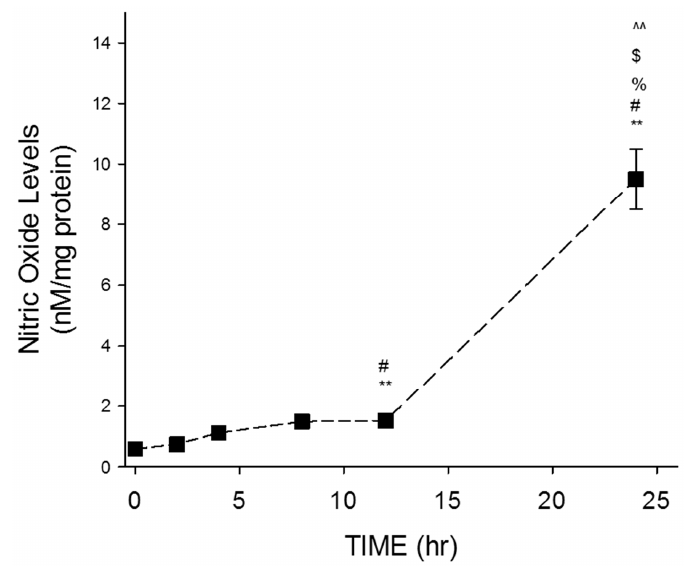
Figure 2. Time-dependent effects of resveratrol on NO levels in GTM-3 cells. Figure shows mean ± SEM ( n = 3). ** = p < 0.05 compared to 0 h, # = p < 0.05 compared to 2 h, % = p < 0.05 compared to 4 h, $ $ = p < 0.05 compared to 8 h, ˆˆ = p < 0.05 compared to 12 h.